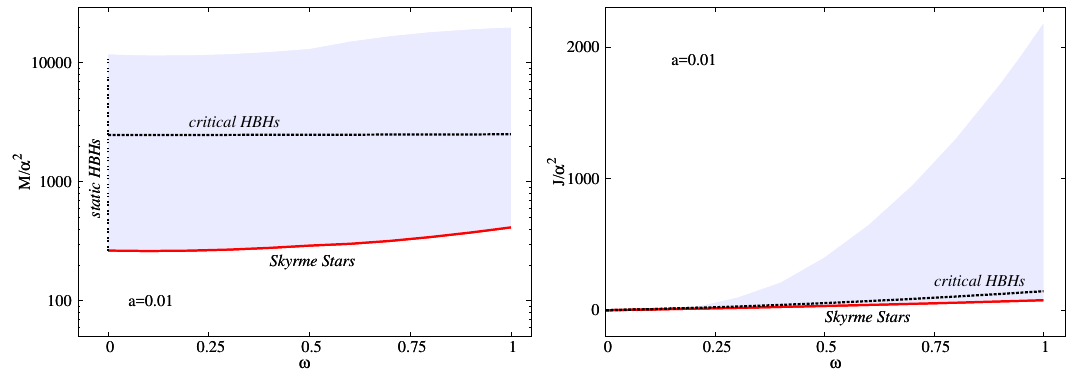
Figure 11 . The domain of existence of the spinning BHs with Skyrme hair is shown in a mass- frequency diagram (left panel) and as an angular momentum-frequency diagram (right